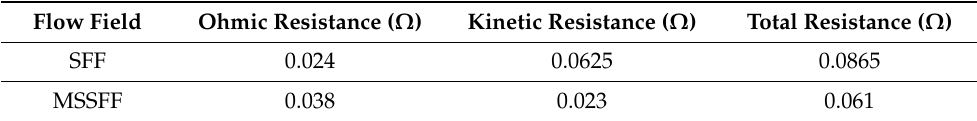
Figure 8. Equivalent Circuit of PEMFC for SFF and MSSFF. Table 3. Values of ohmic resistance and kinetic resistance for SFF and